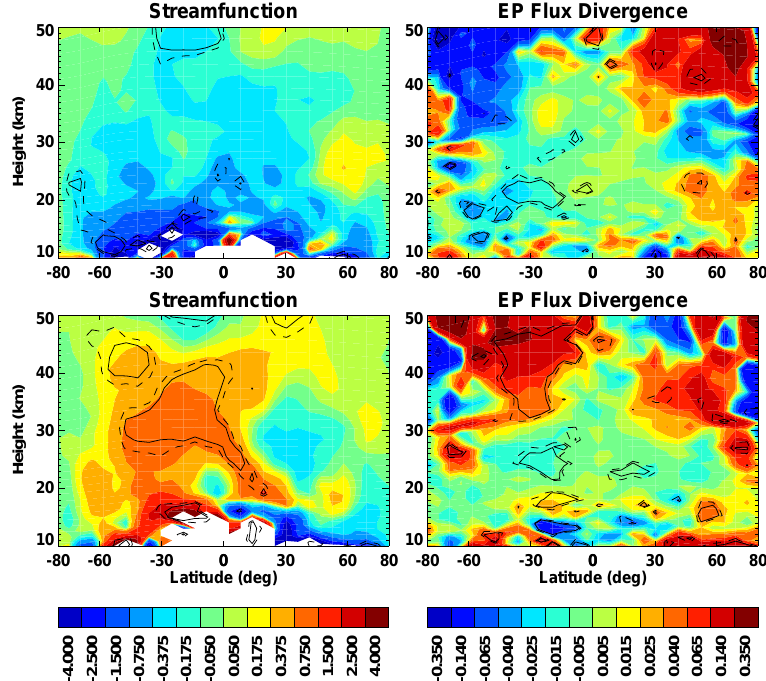
Fig. 20. Latitude-altitude dependence of the annual mean regression coefficient for the solar variability only ensemble mean (top) and for the combined solar variability and EPP ensemble mean (bottom): mass streamfunction (left, kgm − 1 s − 1 per 100 units of F10.7, values outside the ( − 5,5) interval are not plotted) and Eliassen-Palm flux divergence (right, ms − 2 per 100 units of F10.7).